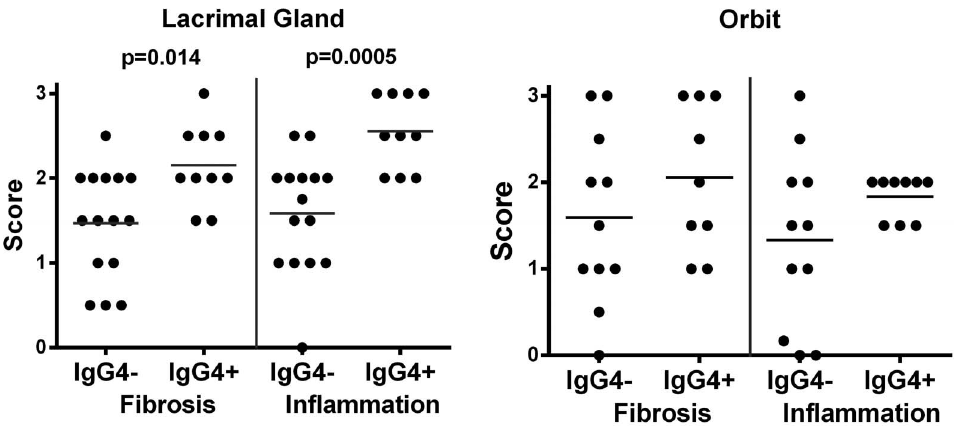
Figure 1. Lacrimal tissues from NSOI patients with at least 10 IgG4 + PC/hpf show increased fibrosis and inflammation. IgG4 + orbit tissues lack the lowest fibrosis and inflammation scores. Each symbol represents the score for one subject. P-values are based on Mann-Whitney U-test.